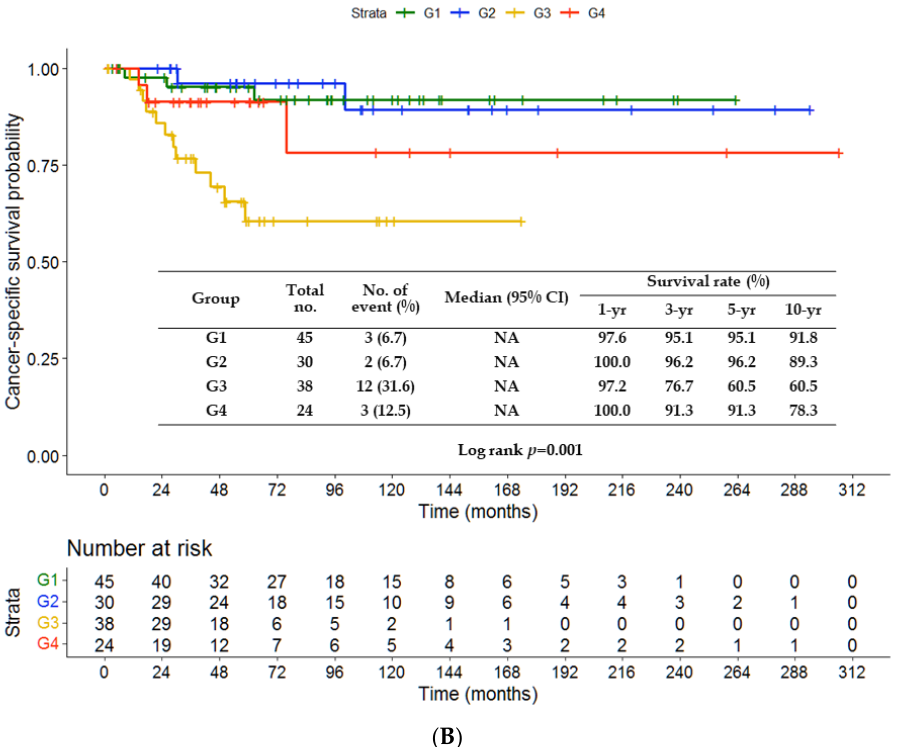
Figure 4. Kaplan–Meier curves of disease-free survival ( A ) and cancer-specific survival ( B ) in terms of tumor size and chemotherapy. G1, size ≤ 4.3 cm without chemotherapy; G2, size ≤ 4.3 cm with chemotherapy; G3, size > 4.3 cm without chemotherapy; G4, size > 4.3 cm with chemotherapy. NA, not available.